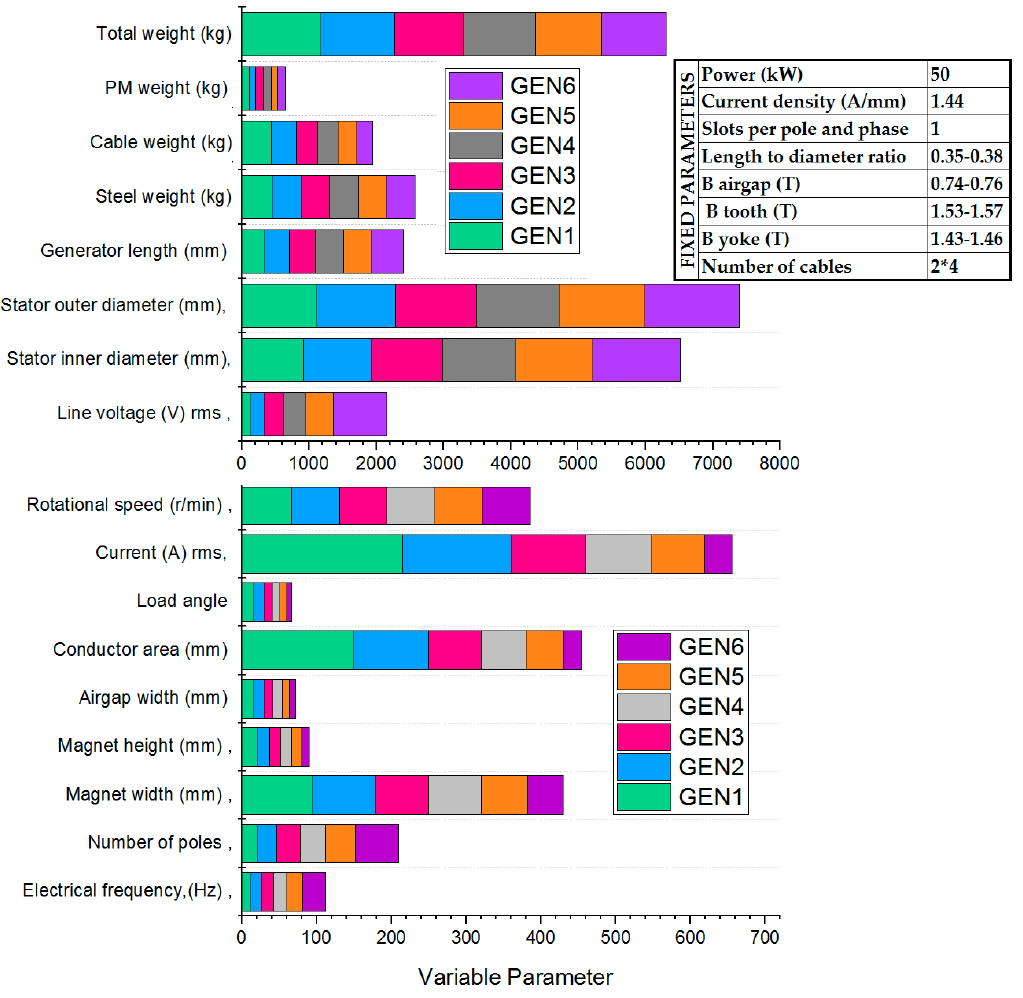
Figure 10. Characteristics of rated speed and power for stationary simulations [33].